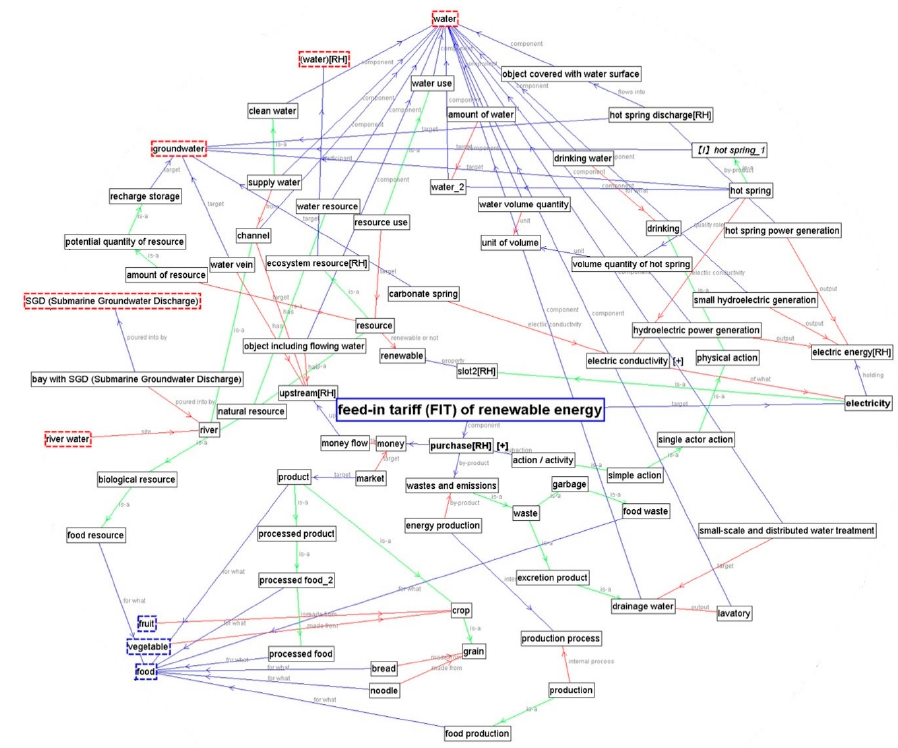
Figure 9. The “feed-in tariff (FIT) of renewable energy”–water–food nexus system map.